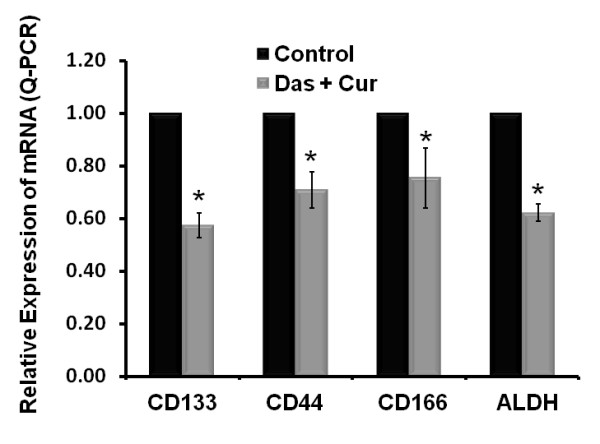
Relative expression of various colon cancer stem cell markers in chemo-resistant HCT-116 cells in response to the exposure to dasatinib (1 μM), and curcumin (10 μM) for 3 days. The controls represent the CR HCT-116 cells that were incubated with FOLFOX (50 μM 5-FU + 1.25 μM oxaliplatin) containing medium only. *P < 0.01, compared with the corresponding control.